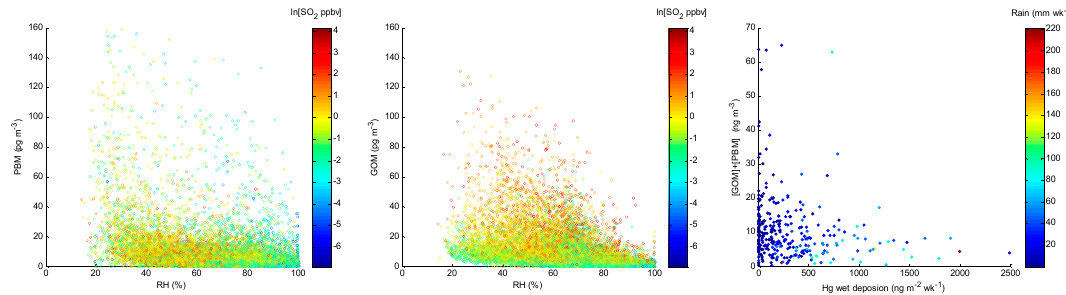
Figure 12. GOM ( left ) and PBM ( middle ) versus relative humidity (RH) colored by SO 2 concentration. ( Right ): [GOM] + [PBM] versus mercury wet deposition colored with rainfall at the Grand Bay site from 2007–2018.